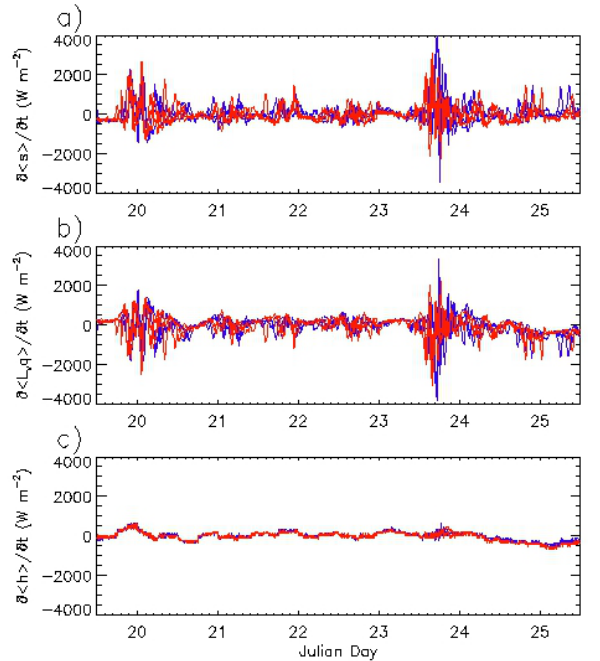
h L v q i h s i Fig. 4. Timeseries of the specified vertically-integrated large-scale , (b) ∂ , and (c) ∂t ∂t 3D advection: (a) h∇ · (sV ) i , (b) h∇ · (L v qV ) i , and (c) h∇ · (hV ) i